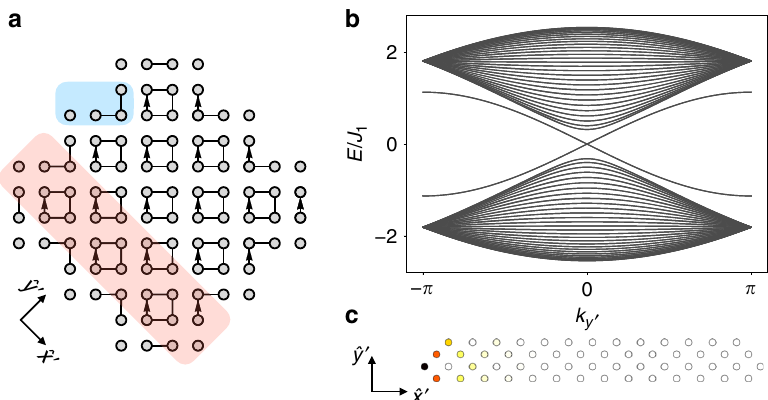
Fig. 4 Open lattice and edge states. a Open lattice in the atomic limit respecting mirror M x , y and C 4 symmetries. Highlighted in blue the edge sites displaying zero modes and in red the unit cell for the stripe geometry. b Energy spectrum obtained by imposing periodic boundary conditions along ^ y 0 and J = 0.8 J 1 2 . Each edge hosts a pair of detached helical edge modes. c Positive energy edge state for